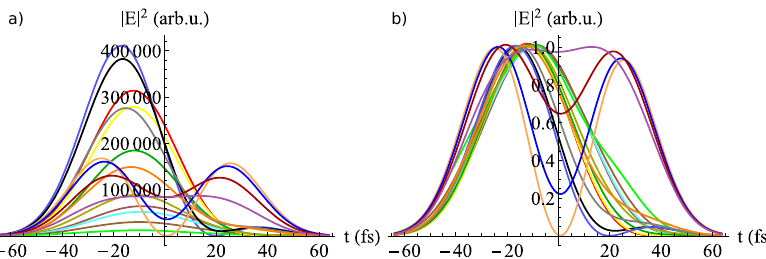
2 ) with AGC = 1.28 mrad/PHz in the focal E | |